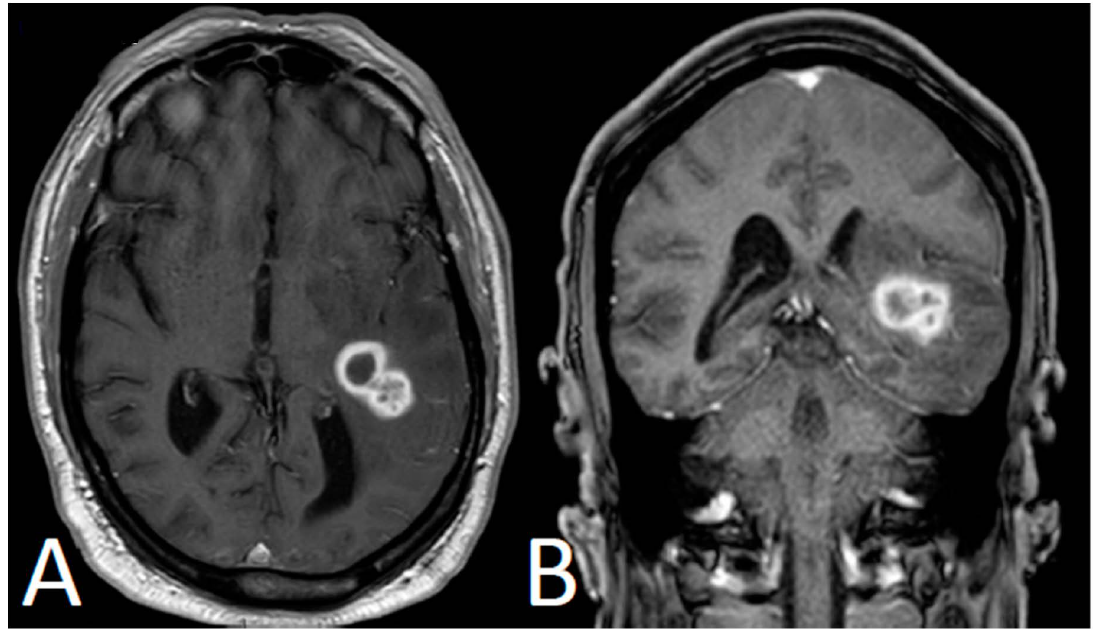
Figure 1. Brain MRI showing lobulated left temporal mass with peripheral enhancement with surrounding cerebral edema ( A : axial view; B : coronal view). surrounding cerebral edema ( A : axial view; B : coronal